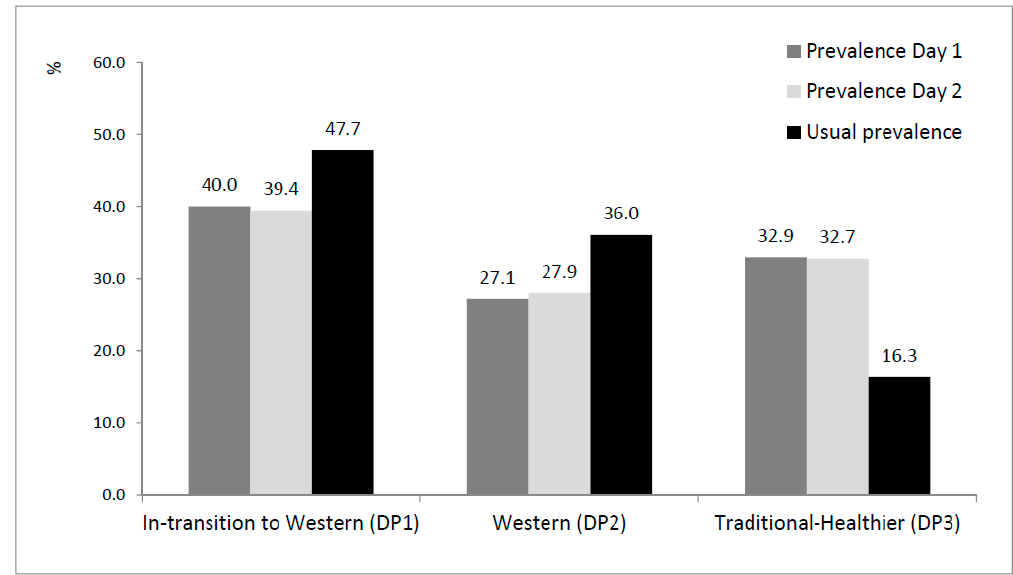
Figure 3. Prevalence of each dietary pattern considering a single recall day (Day 1 or Day 2) and usual prevalence obtained by the latent transition model (without sampling weighting). DP: dietary pattern.